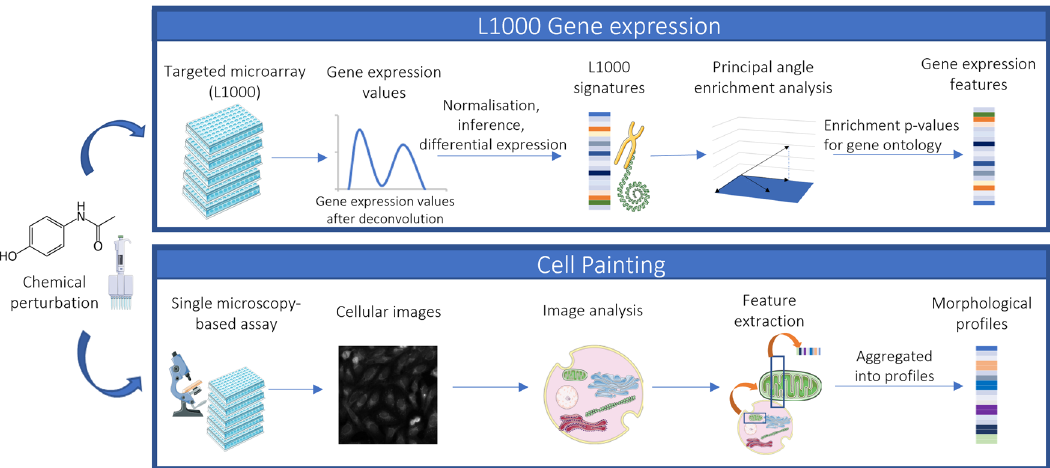
Fig. 2 Overview of the work fl ow employed in this study. L1000 technology for Gene Expression and Cell Painting Technology for cell morphology statistics. The LINCS L1000 gene expression technology pro fi les changes in 978 landmark genes before and after chemical perturbations on different human cell lines. Raw unprocessed fl ow cytometry data from Luminex is converted to quantile-normalized gene expression pro fi les for all replicates of each compound. We use Gene Expression data from Wang et al. 45 , who for each compound, computed the strongest gene expression signature using the Characteristic Direction (CD) method and computed enrichment p values for each CD signature in the space of all genes against gene set libraries using Principal Angle Enrichment Analysis (PAEA). The Cell Painting assay, on the other hand, captures cellular morphological changes in the form of numerical statistics which are converted from microscopic image data of cells treated with chemical perturbations. The Figure was partly generated using